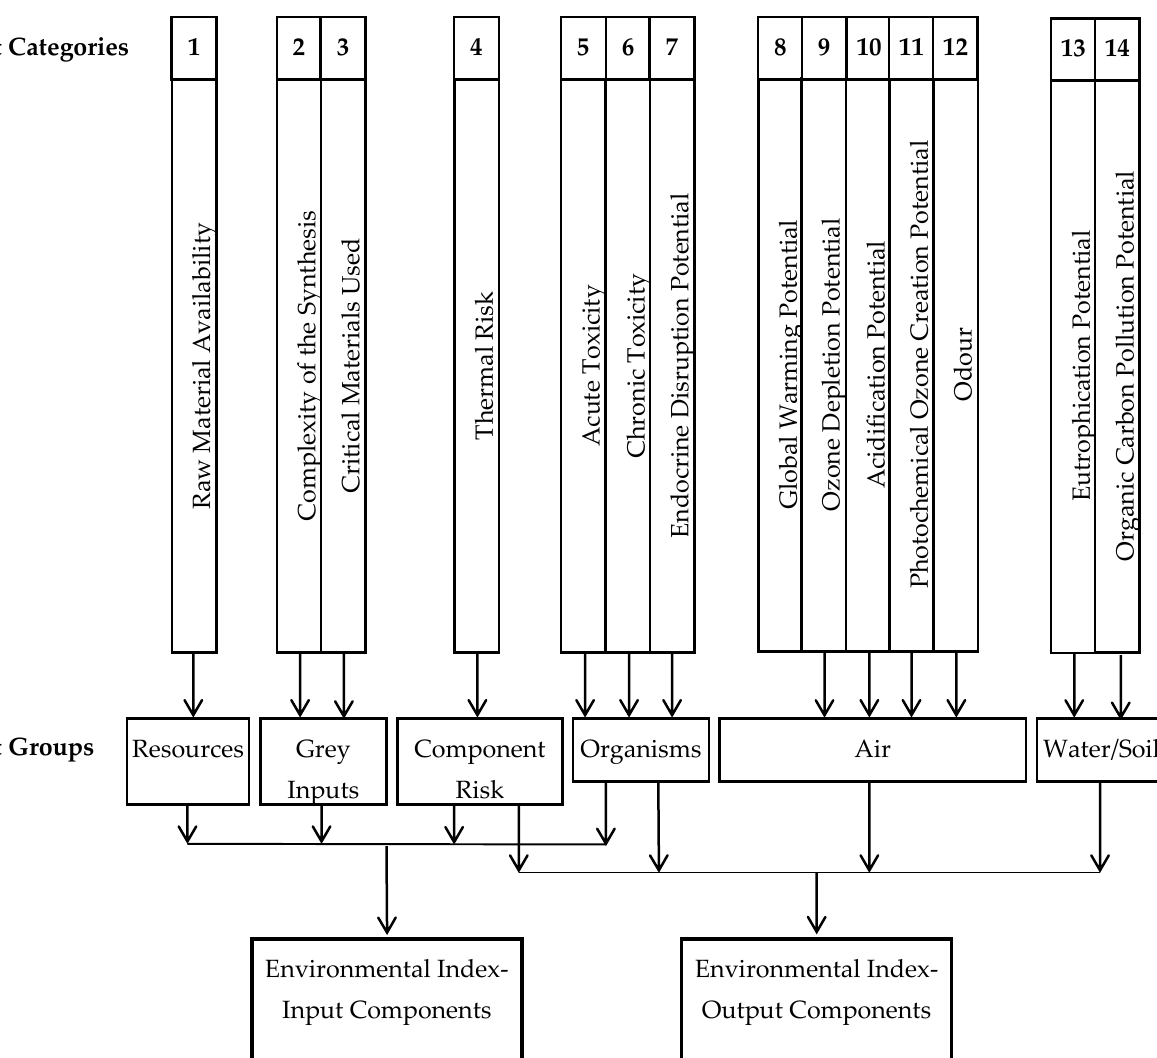
Figure 8. Schematic representation of the Biwer–Heinzle method.